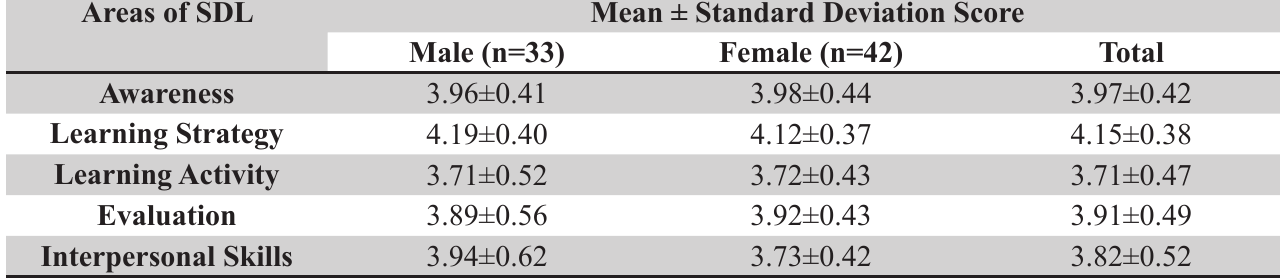
Table 1. Mean score in five broad areas of SDL (N=75).